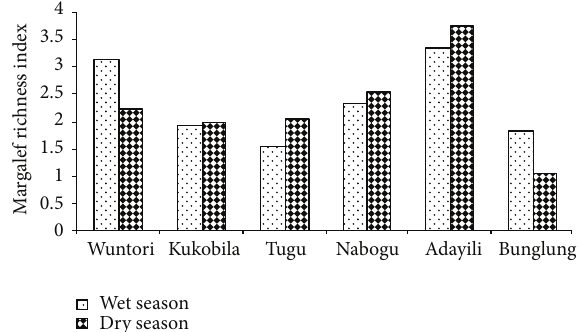
Figure 4: Seasonal changes of fish species richness in the six wetlands.